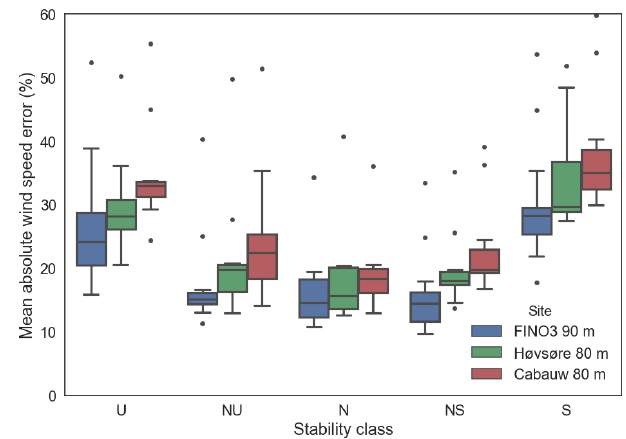
Figure 7. Distribution of mean absolute error (MAE) for wind speed at the three sites for five stability classes: unstable (U), near- unstable (NU), neutral (N), near-stable (NS), and stable (S). See def- initions in Table 2. The boxes represent the second and third quar- tiles. The whiskers extend to the smallest (bottom) or largest (top) value that is within 1.5 times the inter-quartile range. Samples out- side this range are shown as